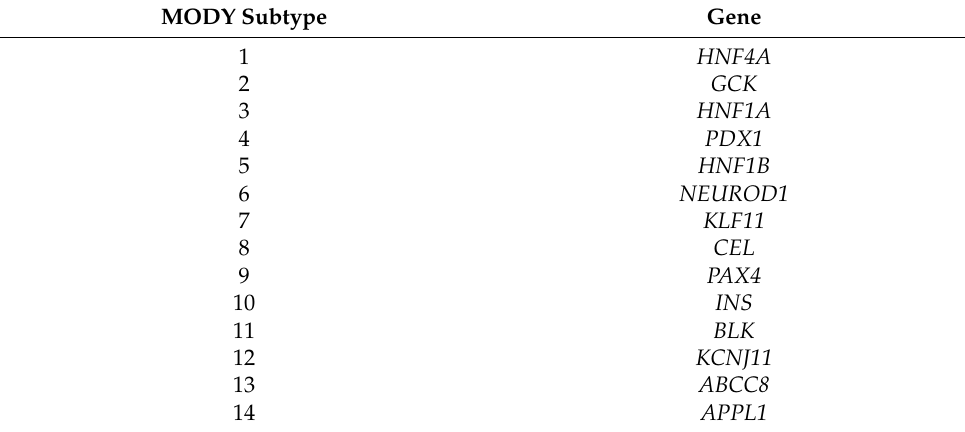
Table 1. MODY subtypes and their related